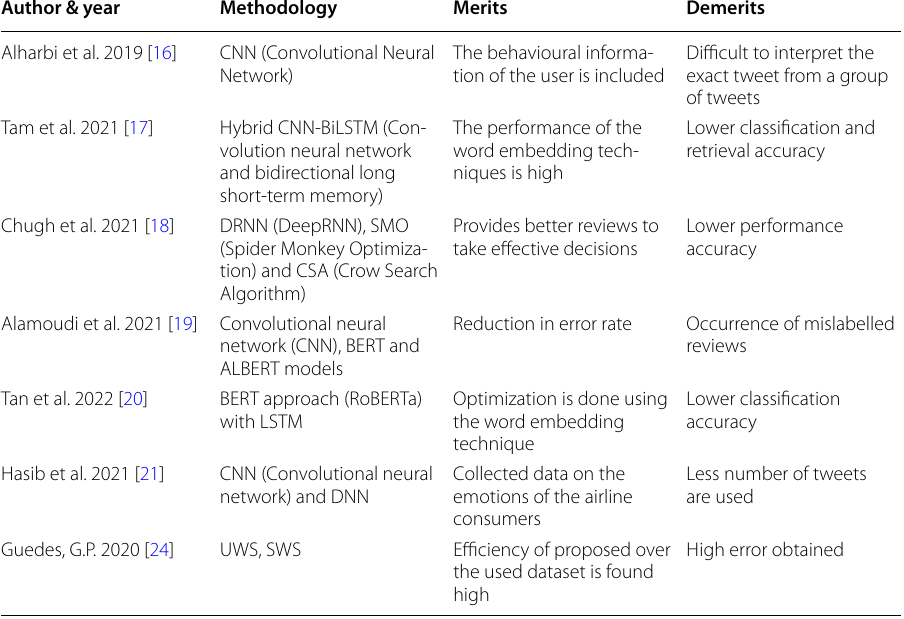
Table 1 Twitter sentiment analysis using DL